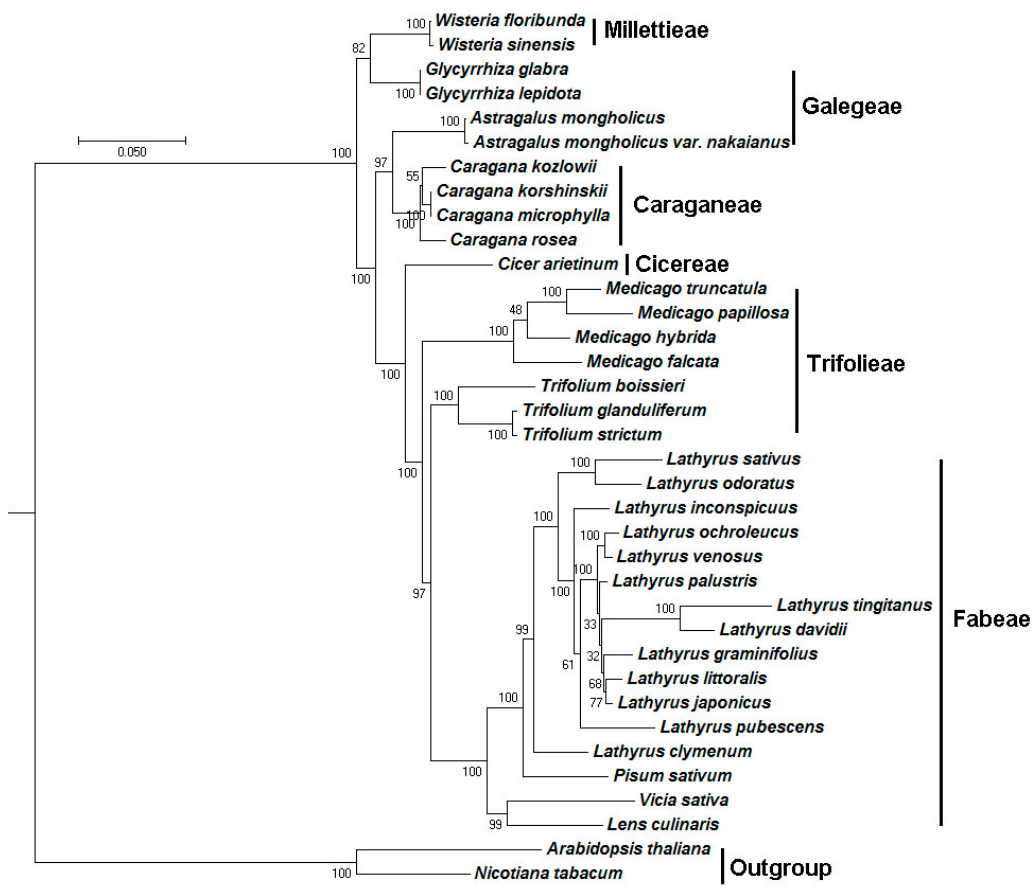
Figure 6. Molecular phylogenetic analyses of plastomes in the inverted-repeat-lacking clade of Papilionoideae. The tree was constructed with the sequences of 63 proteins present in all 36 species by using the maximum likelihood method implemented in RAxML. Bootstrap supports were calculated from 1000 replicates. Nicotiana tabacum and Arabidopsis thaliana were set as outgroups.